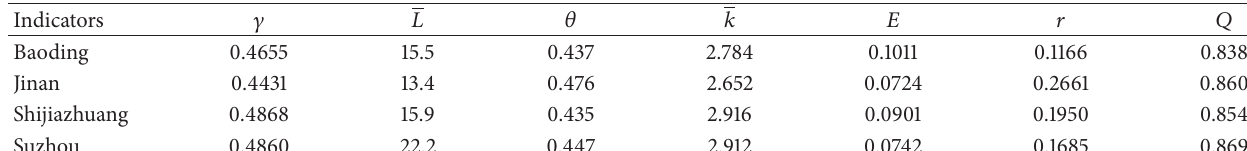
Table 1: Statistical properties values of gamma index, average line length, line overlapping degree, average degree, efficiency, degree correlation, and modularity for Baoding, Jinan, Shijiazhuang, and Suzhou.